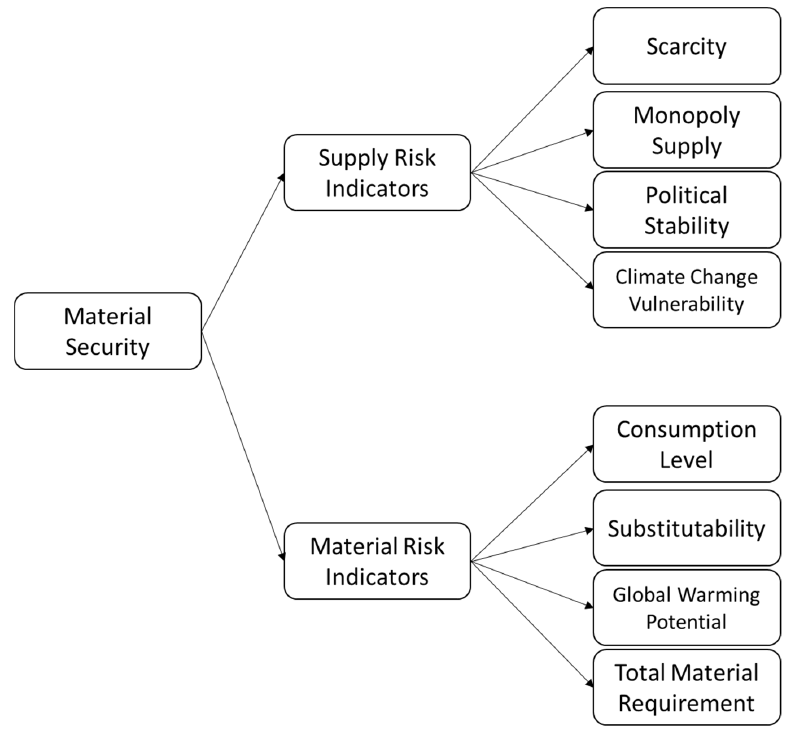
Figure 1. The framework of material security dimensions and indicators.